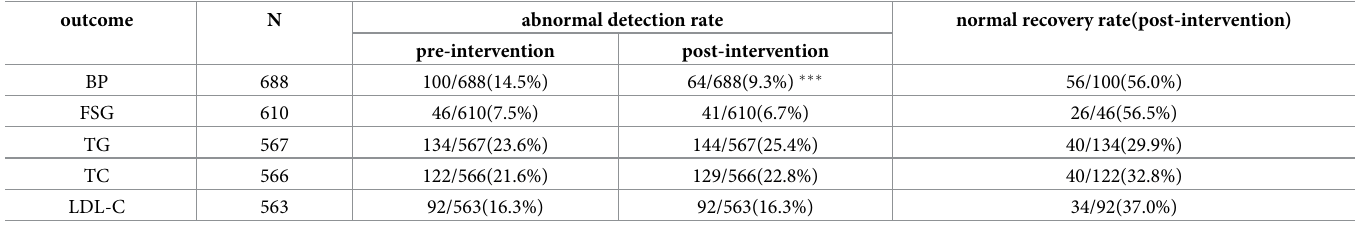
Table 3. Detection rates in pre-, post-intervention and normal recovery rates of hypertension, hyperglycemia, and hyperlipidemia. outcome N abnormal detection rate normal recovery rate(post-intervention) pre-intervention